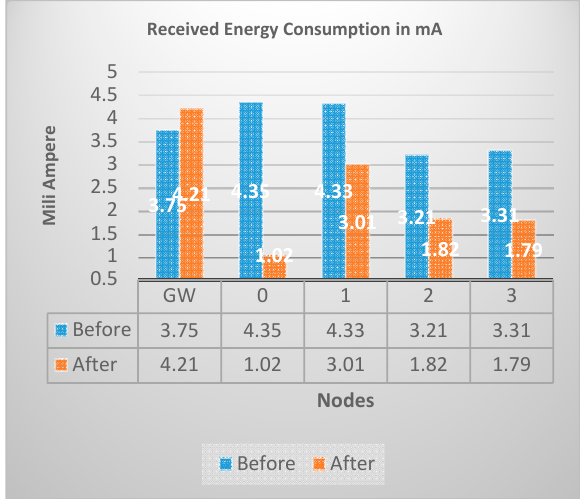
Figure 10. Received Energy Consumption in mA.